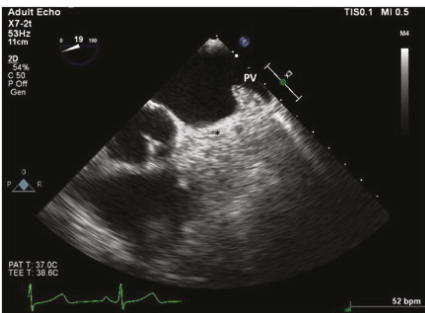
Figure 1: Computed tomography angiogram (CTA) of the pulmonary veins at 47 degrees left anterior oblique (LAO) view showing there is no left atrial appendage on the left atrium.